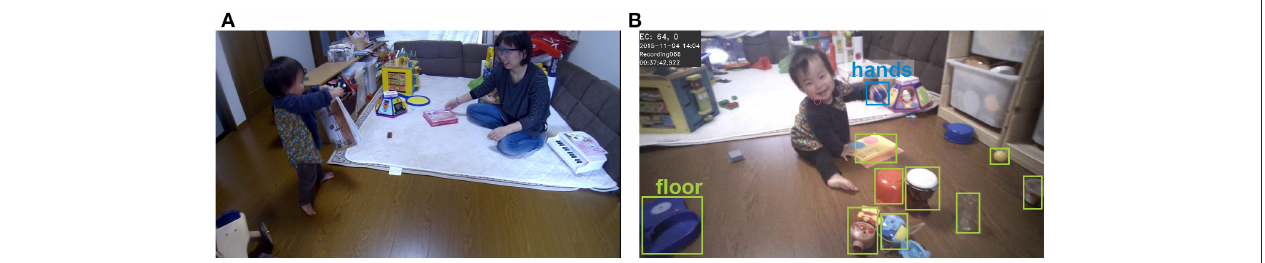
FIGURE 1 | (A) We observed daily infant-parent interaction using head-mounted eye trackers worn by the parents. The infants and parents could move freely in their home environment. (B) Image at the time of eye contact captured from the scene camera of a head-mounted eye tracker worn by a parent. For each eye contact scene, we counted the number of objects on the floor between the dyad (light green) and objects in infant’s hands